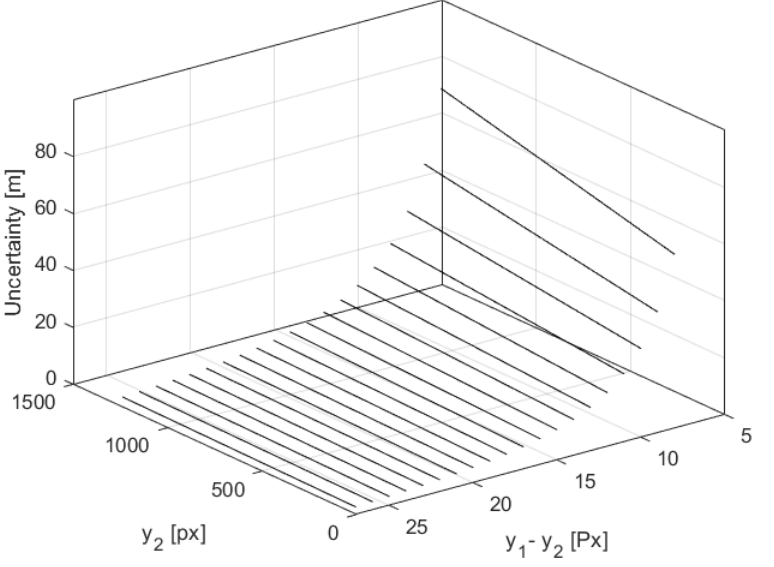
Figure 6. The quantization uncertainty of the distance measurement as a function of the pixel difference, ( y 1 − y 2 ) , and object position on the C 2 image plane, y 2 , within the range of 300